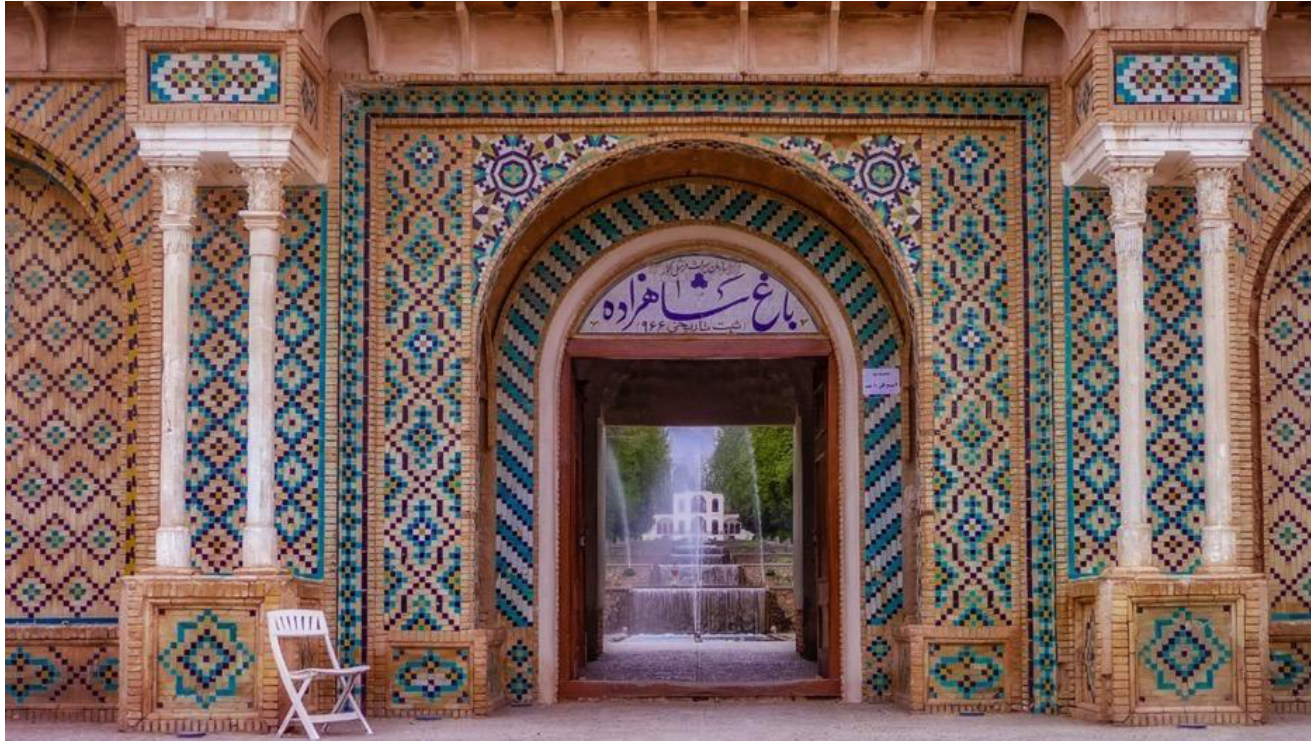
Figure 6. Lintel entrance of Shahzadeh-Mahan Garden. Source: Flicker user ‘my Life, the Universe and